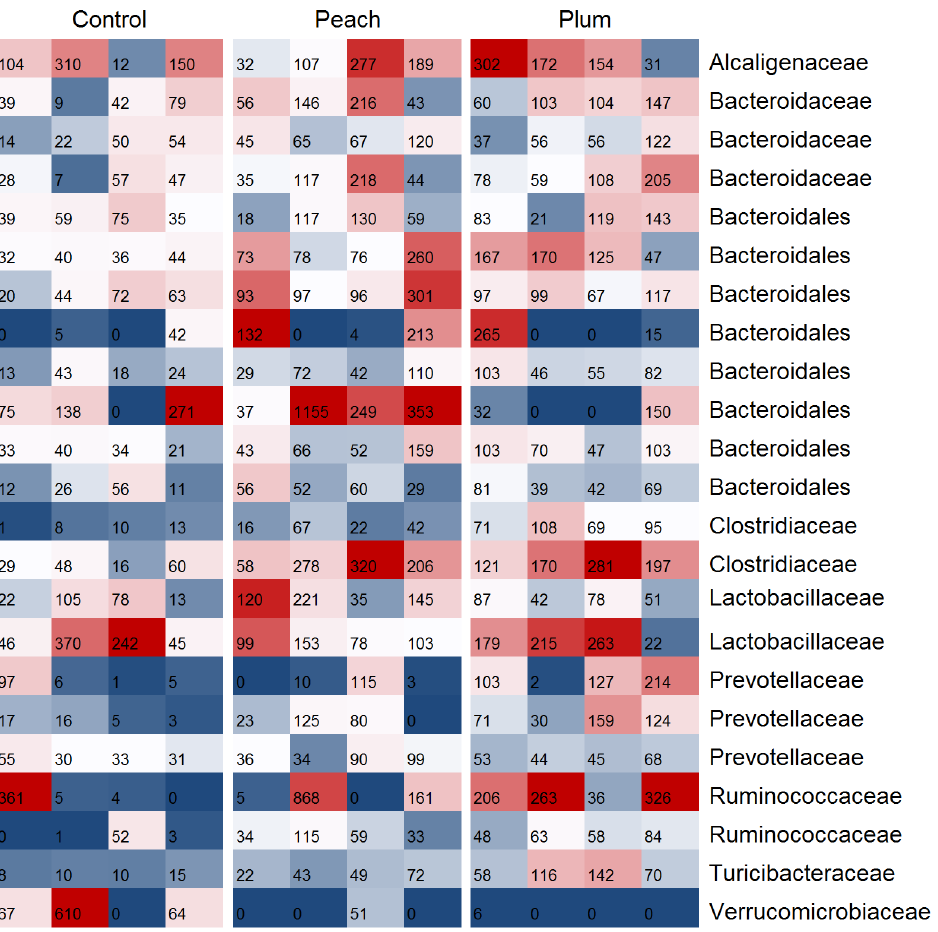
Figure 3. Heat map showing the most abundant operational taxonomic units (OTUs, at least 500 total) in the control (n=4), peach (n=4) and plum (n=4) groups. Colors represent differences in relative abundance within samples (red: higher; white: median; blue: lower).